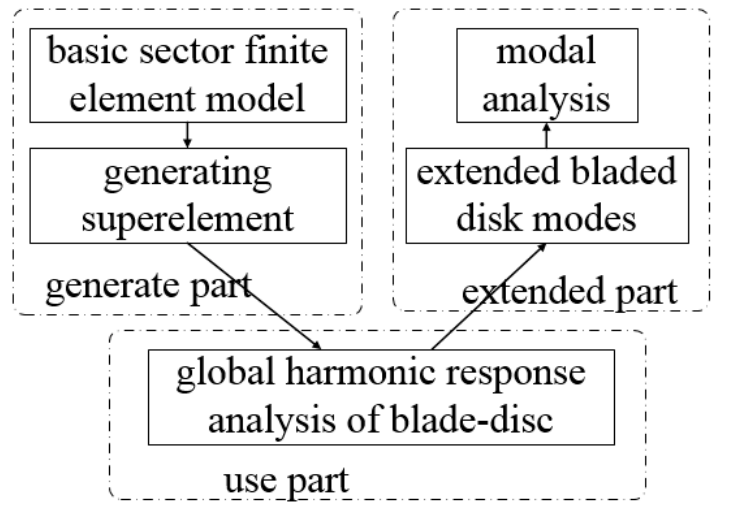
Figure 2. Analysis process of SMSM.